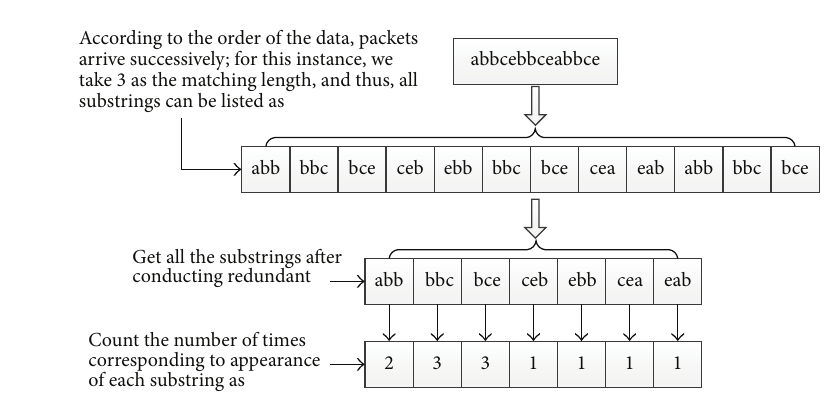
Figure 6: Example of quantization process of frame length